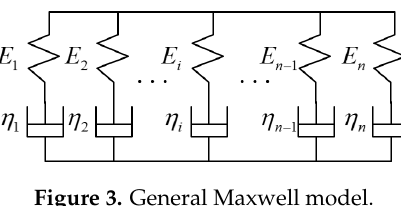
Figure 3. General Maxwell model.